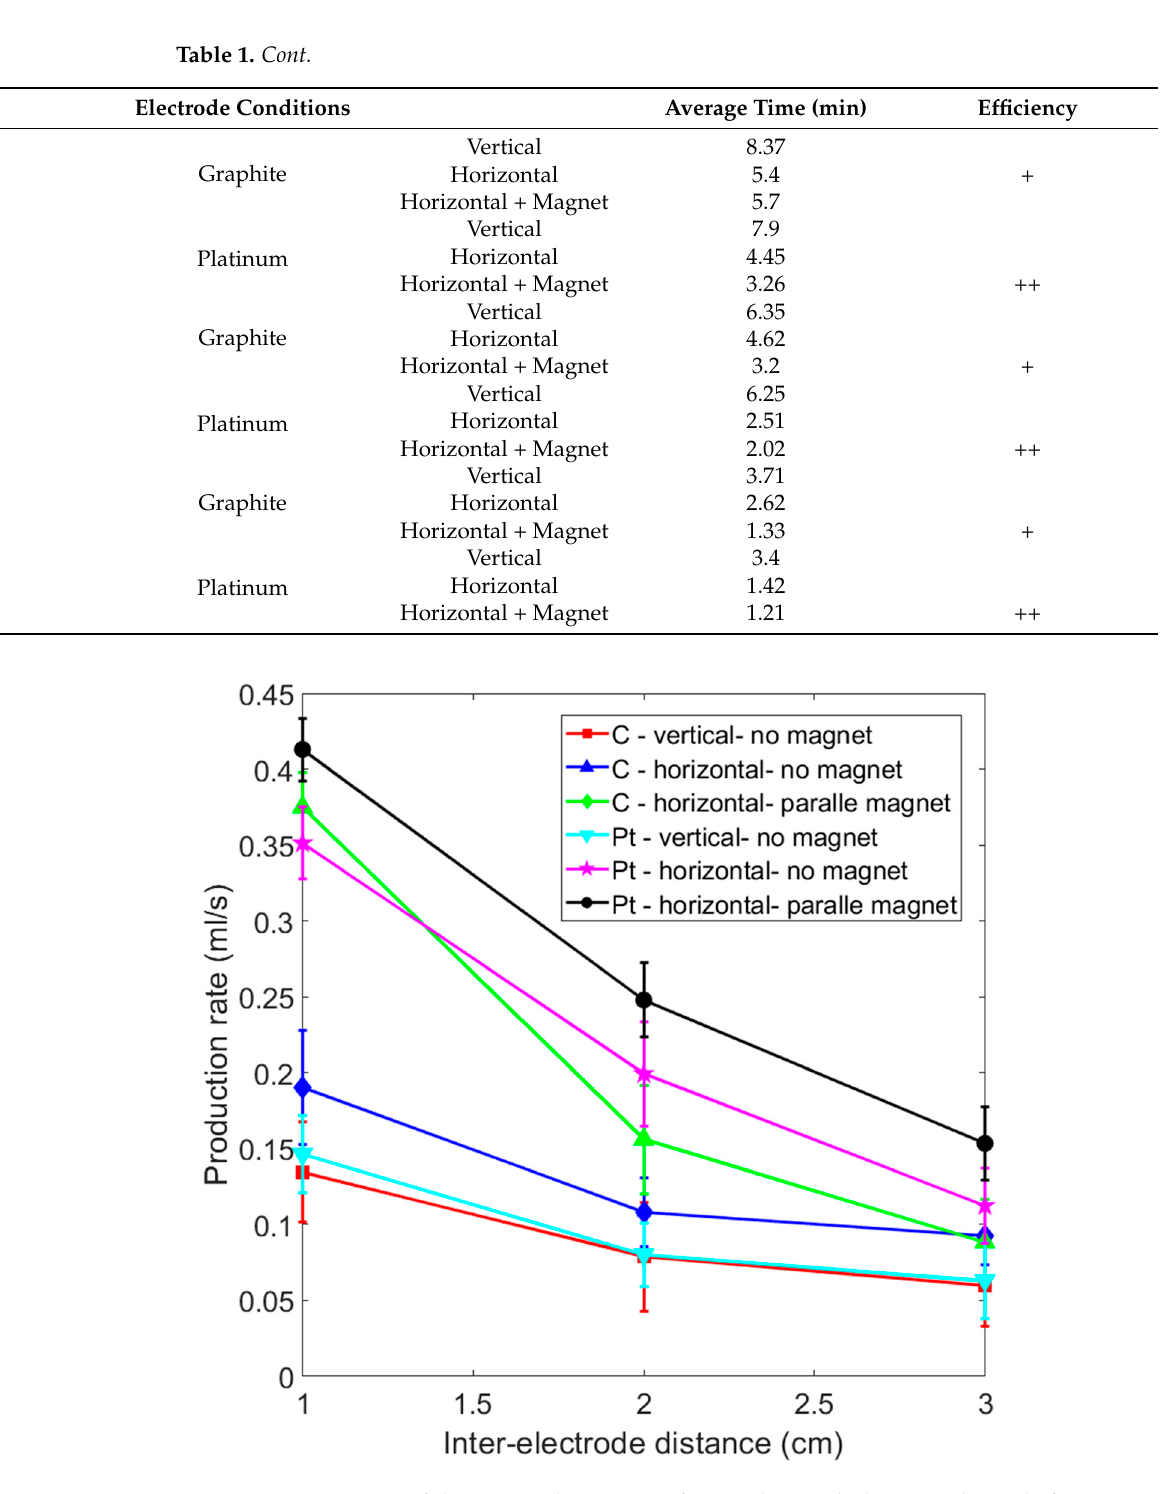
Figure 8. Comparison of the gas production rate for graphite and platinum electrode for various experimental layouts. Table 1. Summary of the optimal hydrogen production efficiency for various electrode and magnet layouts.